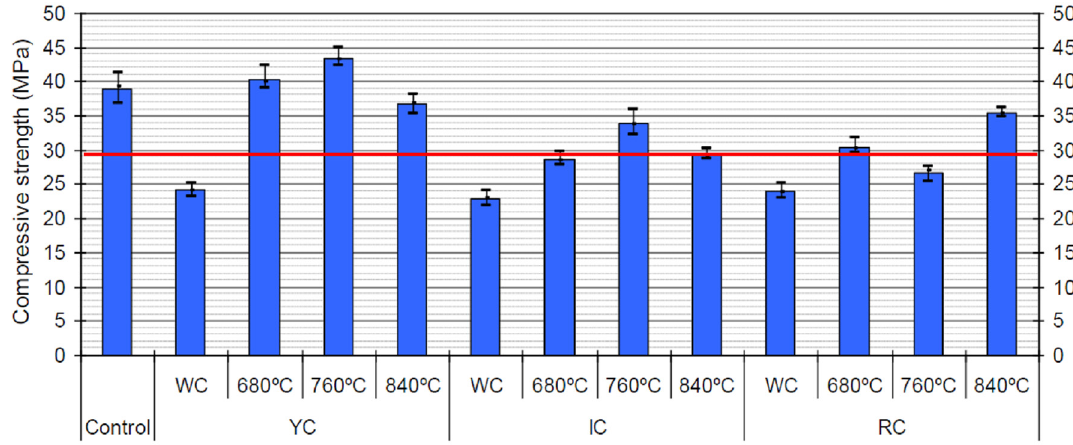
Figure 3. Pozzolanic activity index of cement.